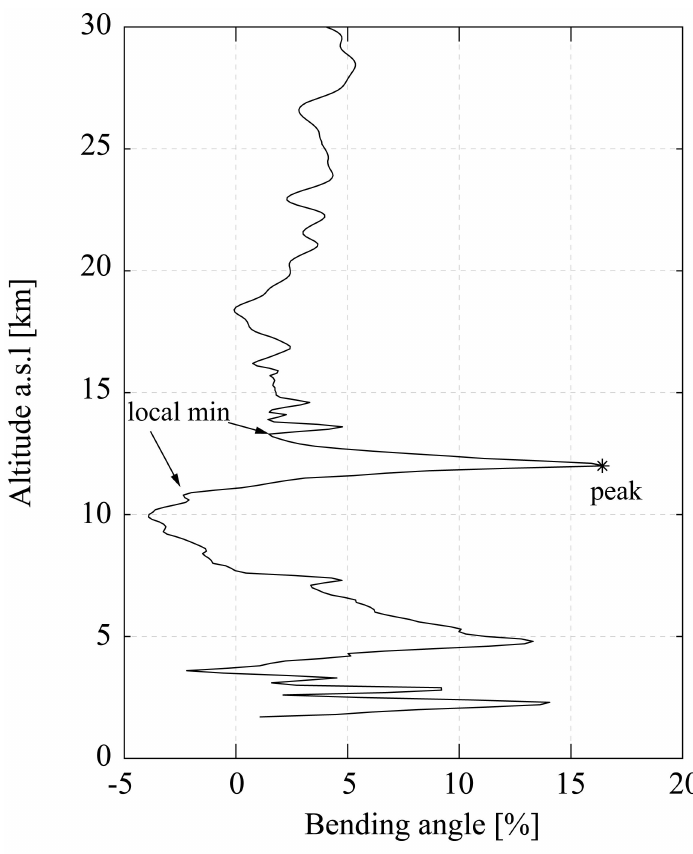
Figure 1. Example of a bending angle (BA) anomaly profile for collocation number 3 also shown in Figure 4c. The y-axis represents the altitude in km above sea level (a.s.l.), while the x-axis represents the BA anomaly expressed as a percentage with respect to the reference climatology. The peak corresponding to the volcanic cloud is highlighted with a star, while the arrows indicate the local minima that the algorithm uses to detect the